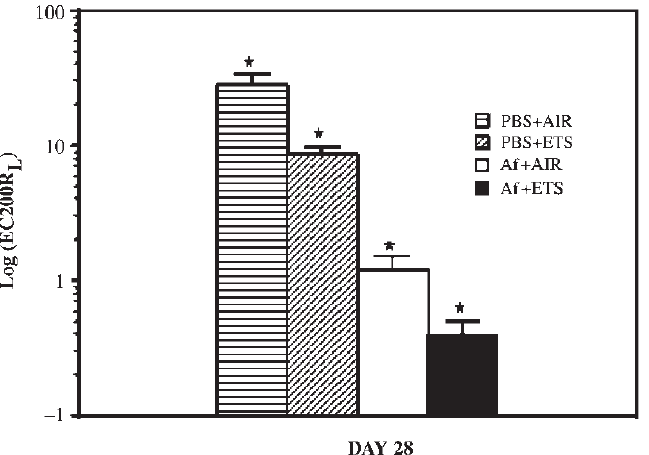
FIGURE 2 The effect of Af and ETS on airway responsiveness to acetylcholine aerosol in BALB/c mice. Animals were given 25 m g Af per exposure or PBS as described in Fig. 1 and airway responsiveness was measured on day 4 after the final i.n. sensitization. Airway responsiveness is expressed as the